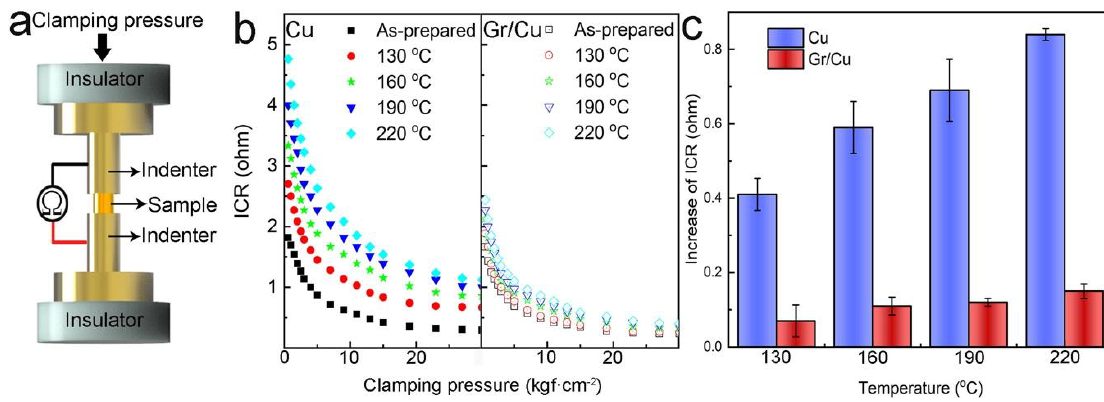
Figure 4. ( a ) Scheme of self-built equipment used for interfacial contact resistance (ICR) measurements. ( b ) ICR as a function of the clamping pressure for Cu counterpart and Gr/Cu composites thermally treated at different temperatures and ( c ) the corresponding ICR increases.